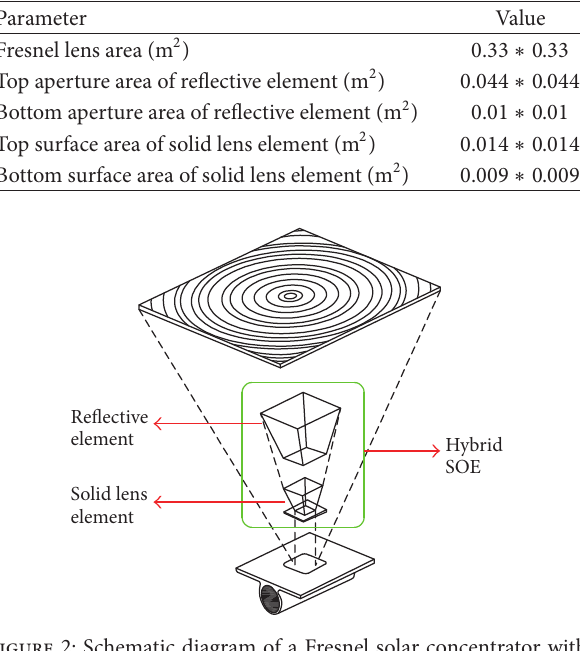
Figure 2: Schematic diagram of a Fresnel solar concentrator with the hybrid SOE.